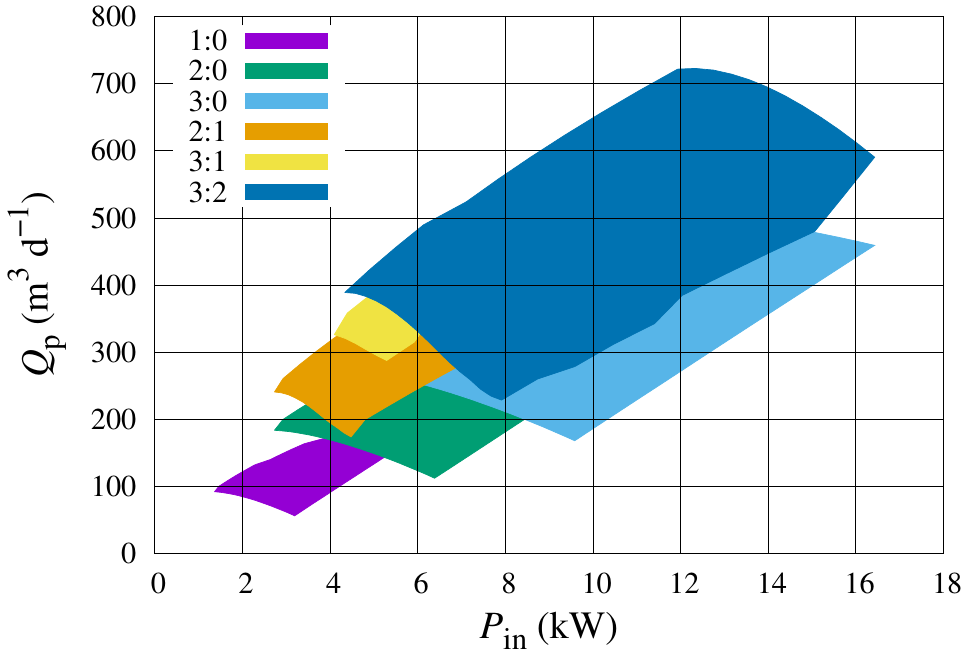
Figure 3. Permeate production for different BWRO configurations using sample 20 (Table 1) as C f